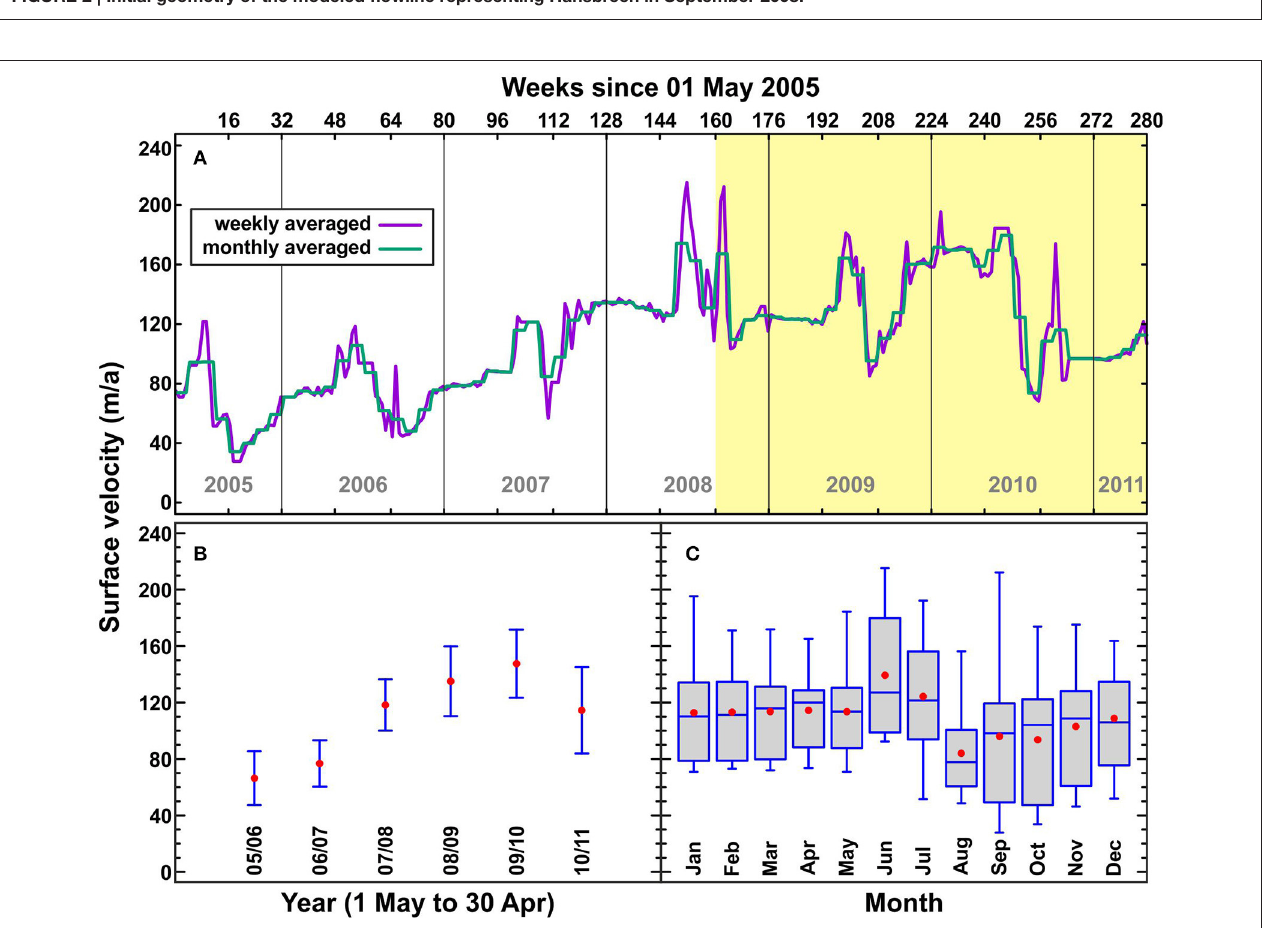
FIGURE 3 | (A) Glacier surface velocities (purple line: weekly averages, green line: monthly averages) measured at the stake closest to the calving front. Yellow highlighting represents the modeled period. (B) Annual means and standard deviations of the glacier surface velocities from 1 May to 30 April the following year. (C) Box-and-whisker plot (computed using Statgraphics ® centurion) of glacier surface velocities by month for all years (red dots: means, blue interior lines: medians). by a gradual speed up through the winter ( Figure 3A ).